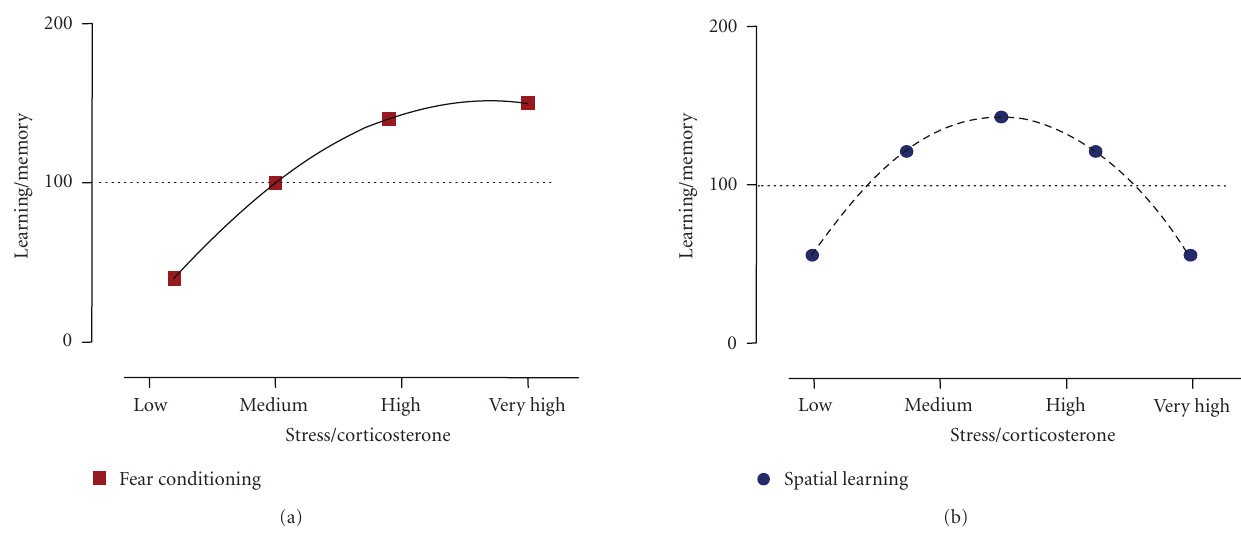
Figure 3: Impact of “intrinsic” stress on learning acquisition. Figures representing the linear-asymptotic—typical for fear conditioning— (a) and inverted U-shape—typical for spatial learning—(b) relationships between stress intensity (either defined by the stressor or by the physiological response indexed by the glucocorticoid corticosterone) experienced during the learning period and the degree of learning and memory